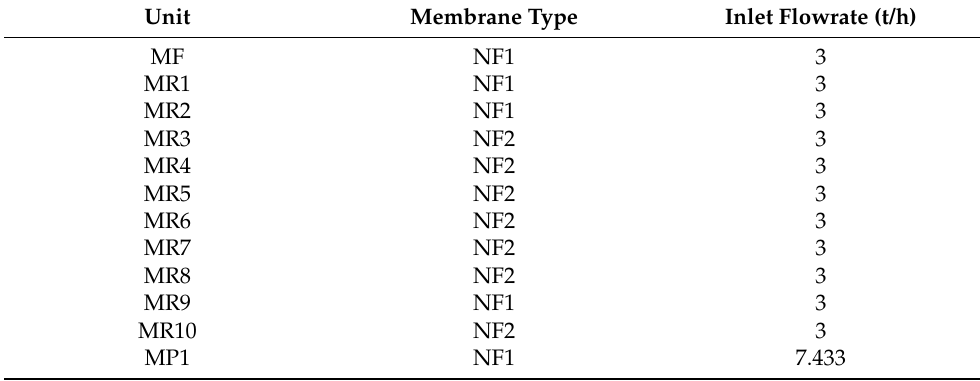
Table 3. Selection of membrane types for scenario